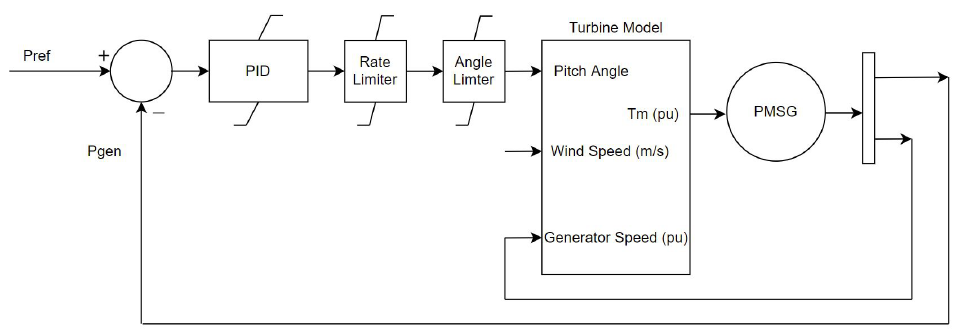
Figure 7. Control and Simulation Diagram for the Non-Pilot Generators.